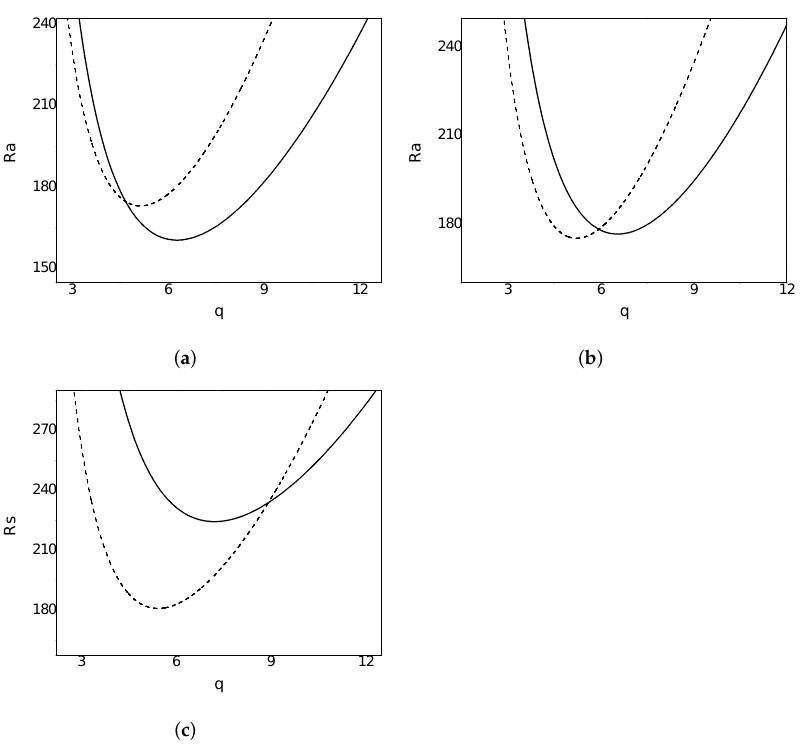
Figure 6. Neutral curves (solid lines represent the stationary convection and dotted lines represent the oscillatory convection) for Dm = 20, Ha = 0.6, Va = 20: ( a ) Ta = 2.5, ( b ) Ta = 3.1, ( c ) Ta =